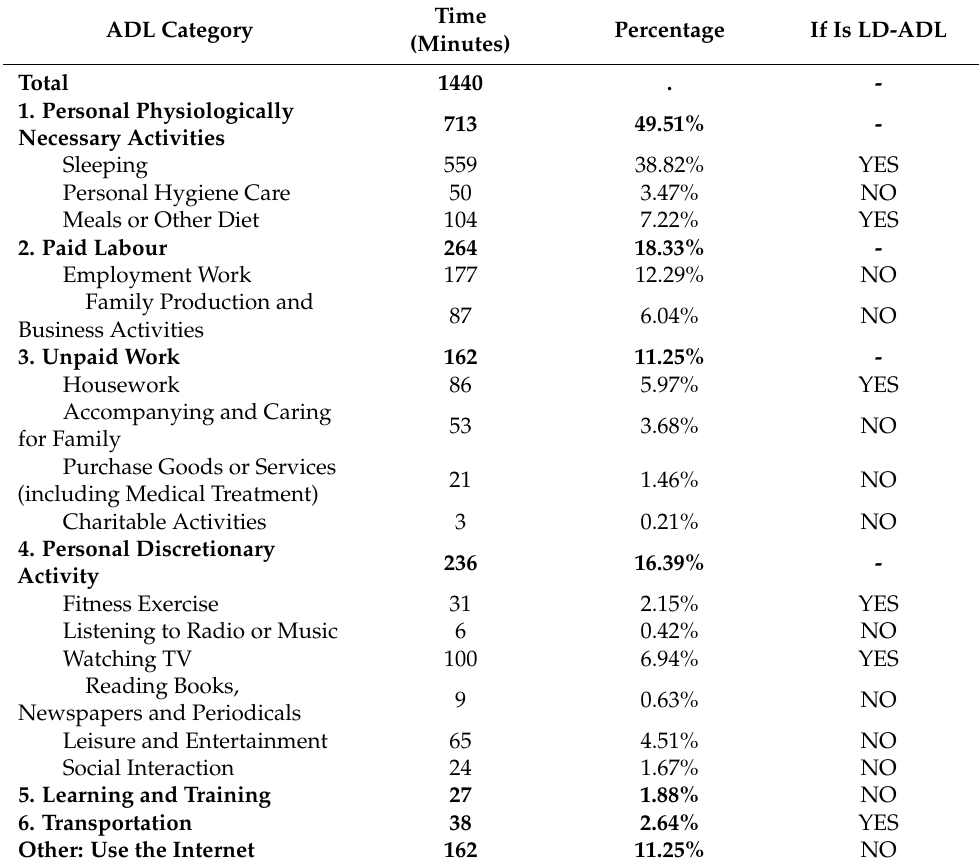
Table 1. Average time of main activities of residents of China in